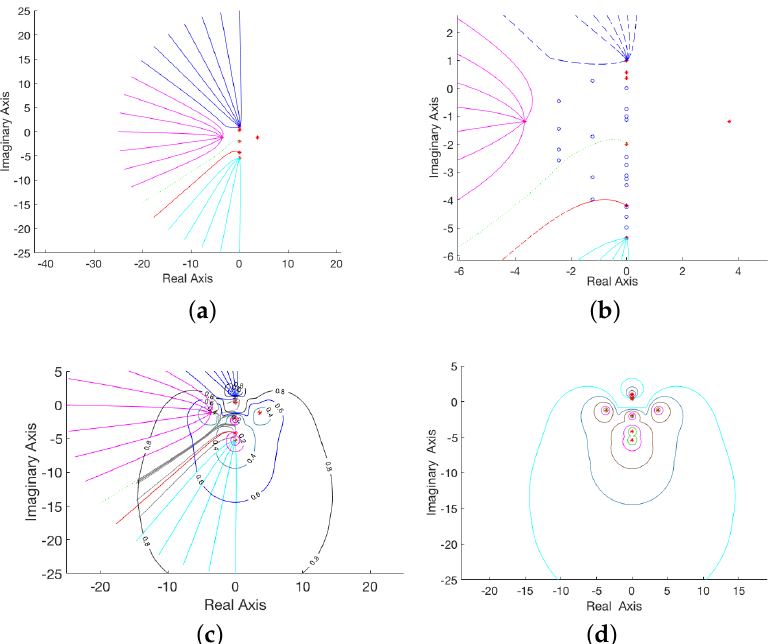
Figure 8. Comparison of pseudospectra computation for a gyroscopic system and (cid:101) = 0.1, 0.2, 0.4, 0.6, 0.8. ( a ) Cluster detection using 21 initial points. ( b ) Locations of additional points. ( c ) Pseu- dospectra visualizations interpolating along the trajectories of 21 initial and 20 additional points. ( d ) Pseudospectra visualization, using the modified grid algorithm in